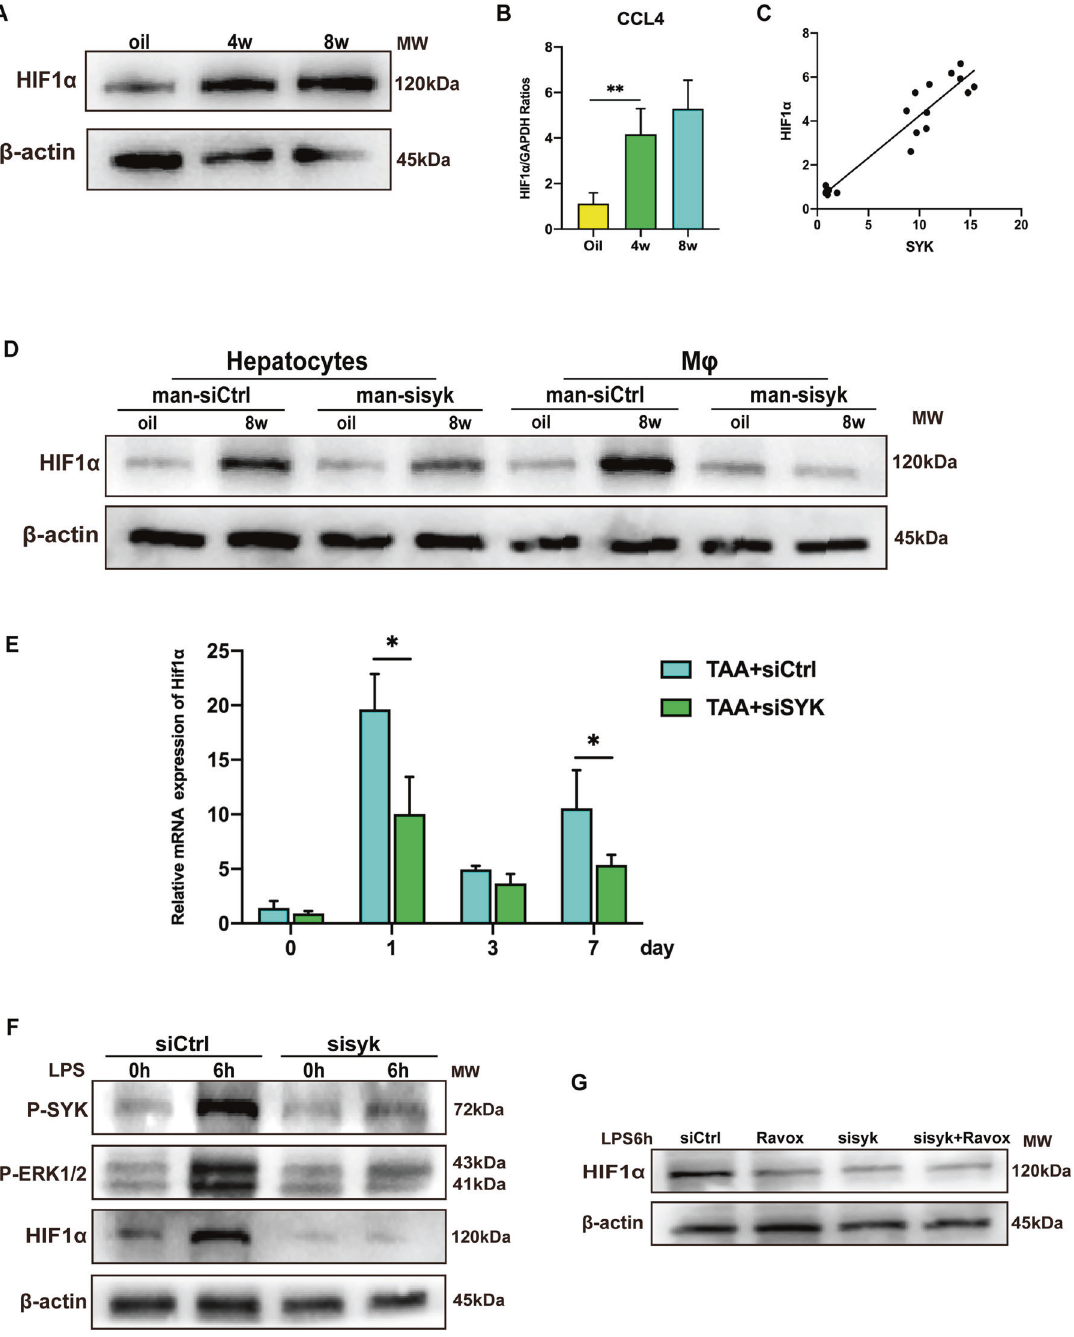
Fig. 4 SYK regulates Hif1 α transcription depending on Erk phosphorylation. HIF1 α A protein and B mRNA levels were measured after CCL4 injection for 4 weeks and 8 weeks by Western Blot or PCR; C The correlation analysis of the expressions of SYK and HIF1 α in CCL4 models (** p < 0.01); D The hepatocytes and macrophages expression of Hif1 α in siCtrl and siSYK fi brotic livers. E And, 4 h before TAA injection, mice were injected with siCtrl and siSYK through the tail vein, and determine the transcription of Hif1 α in the liver 1, 3, and 7 days after TAA injection Level (* p < 0.05); F Transfect mouse BMDM with shSYK lentivirus, then stimulate BMDM with LPS for 6 h, detect the protein levels of p-SYK, p-Erk1/2, HIF1 α in macrophages; G The protein level of HIF1 α in BMDM in the presence or absence of siSYK or Erk1/2 inhibitor